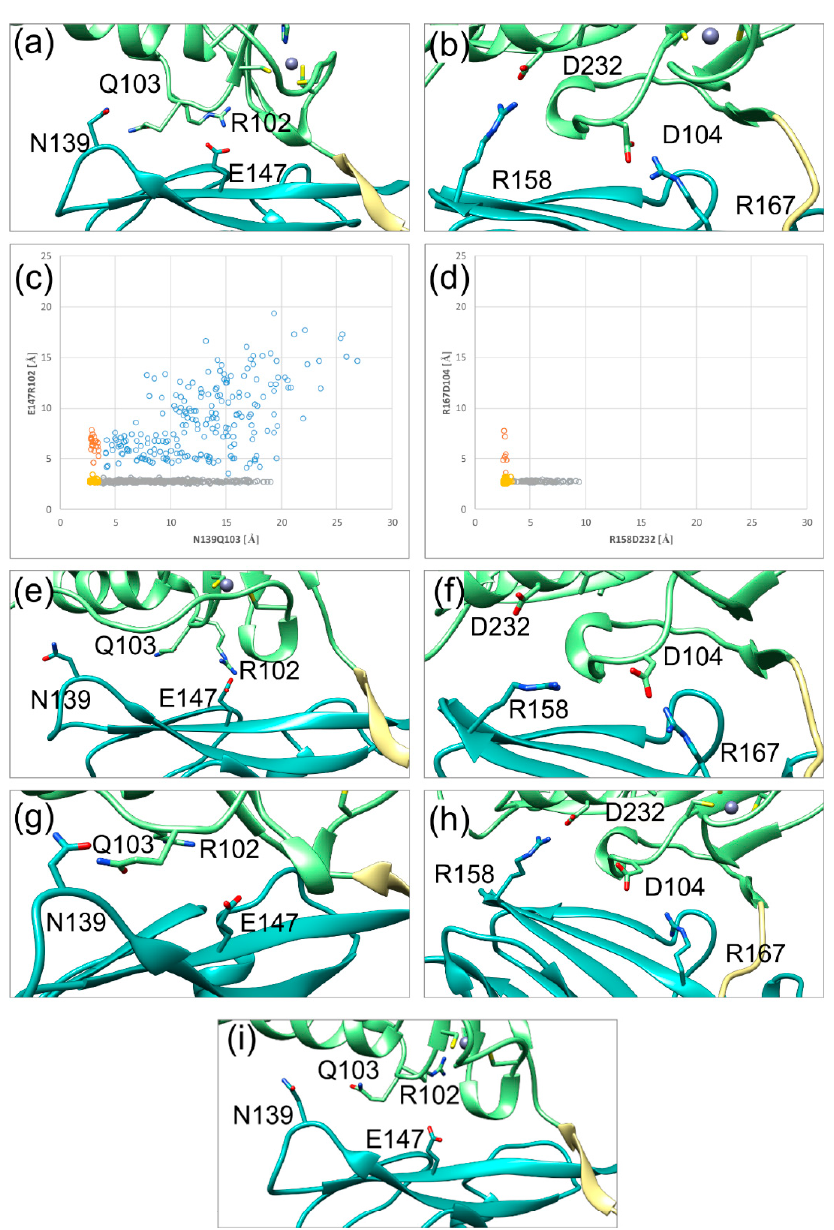
Figure 5. Fluctuations of the SIF (secondary interface) over the simulation time in HCMV (left) and HSV ‐ 1 (right) NECs. The pUL50(pUL34) subdomain, pUL53(pUL31) subdomain, and hook region are coloured in cyan, green, and khaki, respectively, in agreement with the scheme established in Figure 1. ( a ) The HCMV NEC SIF with two stable polar interactions. ( b ) HSV ‐ 1 NEC SIF with two stable polar interactions. ( c ) Distribution of the distances of both HCMV NEC SIF polar interactions against each other; the yellow dots represent two stable interactions, the grey and orange dots correspond to one stable interaction each, the blue dots indicate no stable interaction. ( d ) Distribution of the distances of both HSV ‐ 1 NEC SIF polar interactions against each other; colour coding as in ( c ). ( e ) HCMV NEC SIF conformation, in which the N139Q103 interaction distal to the hook is lost. ( f ) HSV ‐ 1 NEC SIF conformation, in which the D232R158 interaction distal to the hook is lost. ( g ) HCMV NEC SIF conformation, in which the R102E147 interaction proximal to the hook is lost. ( h ) HSV ‐ 1 NEC SIF conformation, in which the D104R167 interaction proximal to the hook is lost. ( i ) HCMV NEC SIF, in which both polar interactions are lost. This situation is only observed for HCMV, but not for HSV ‐ 1. Distance plots of both polar interactions against each other illustrate the difference in stability and the co ‐ occurrence of both interactions (Figure 5c,d). In HSV ‐ 1, both salt bridges are simultaneously present for most of the simulation time (yellow dots in Figure 5d). When the salt bridges are lost, the sidechain distances can reach up to ~9 Å (orange and grey dots in Figure 5d). Notably, at least one of the salt bridges remains intact during the simulation time, thus offering a structural explanation for the rather high rigidity of domain orientation. By contrast, the plot for the HCMV NEC shows a fourth region, in which both interactions are lost (blue dots in Figure 5c). In addition, the distance between N139 and Q103 can increase up to very high values of almost 20 Å, even when the proximal E147R102 salt bridge is present (grey dots in Figure 5c). These observations are in line with the poorer interface packing and larger conformational freedom for the subdomain orientation in HCMV compared to HSV ‐ 1 (Figure 5c). Representative interface regions resulting from the loss of one or two polar interactions are depicted in Figure 5e–i. The results presented, so far, suggest subfamily ‐ specific dynamics for the SIF of heterodimeric NECs. While the SIF of α‐ herpesviral NECs appears to be rather rigid, the SIF of the HCMV NEC is highly flexible by itself, and lacks the strong polar interactions of HSV ‐ 1 and PRV. In contrast to the PIF, which possesses a multitude of essential interactions in all NECs, essential residues in the secondary interface have only been reported for the α‐ herpesviral NECs. In particular, mutations of the two salt bridges have been shown to abolish pUL34 ‐ pUL31 binding altogether [26,27]. 2.4. HCMV NEC Secondary Interface Can Be Stabilized by Introducing an Extra Salt bridge To test the hypothesis, that the lack of a salt bridge distal to the hook in the secondary interface is responsible for the twist between subdomains in the HCMV NEC, a salt bridge was introduced at a suitable site. By mutating N139 of pUL50 to arginine and H99 of pUL53 to aspartate (Figure 6a), a significantly more stable interaction (61% persistence) can be formed. Interestingly, the stability of the second (E147R102) salt bridge is almost unaffected (Figure 6b). However, a simultaneous loss of both interactions is a rare event (Figure 6b,c), which corresponds to a transient conformational instability observed in run 2, from 30 to 80 ns (Figure 6c, orange line), which is characterized by a large twist angle (Figure 6d). Thus, there is a strong correlation between the simultaneous loss of both salt bridges and the occurrence of large twist angles (Figure 6c,d). The newly introduced salt bridge is strong enough to reduce the average twist between subdomains compared to the wildtype NEC (Figure 4e). Even though the introduction of R139D99